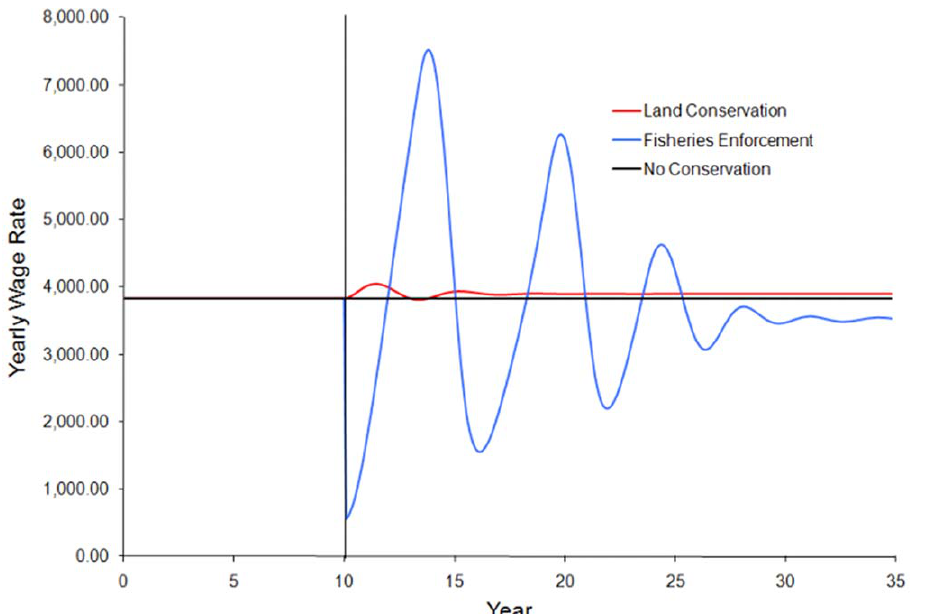
Figure 4. Impacts of the various marine conservation strategies on the yearly wage rate. Conservation strategies are implemented at year 10, denoted by the vertical line. Land conservation leads to an increase in the wage rate, while fisheries enforcement decreases the wage rate.